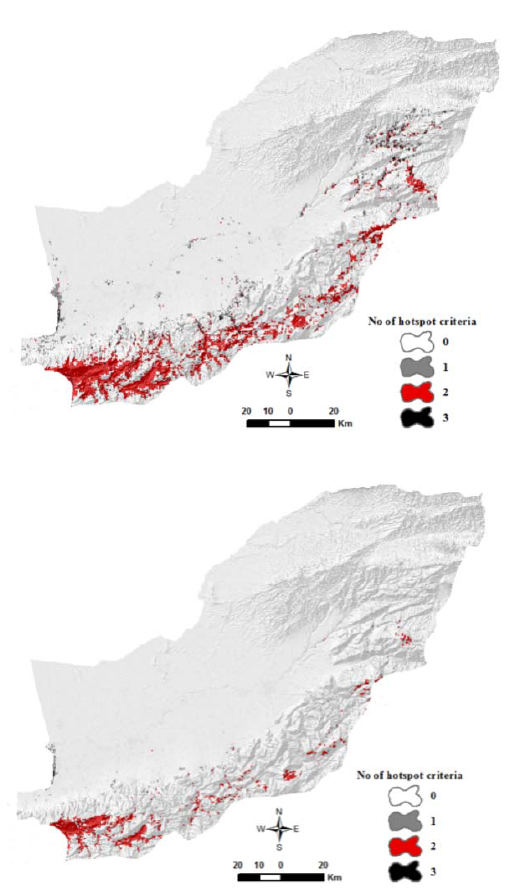
Fig. 5: Map of three hotspot criteria in Golestan Province; combined colors range from black (all three hotspot criteria fulfilled) to gray (only one of three hotspot criteria fulfilled). Left side is 30% criterion view, right side is 20% criterion view